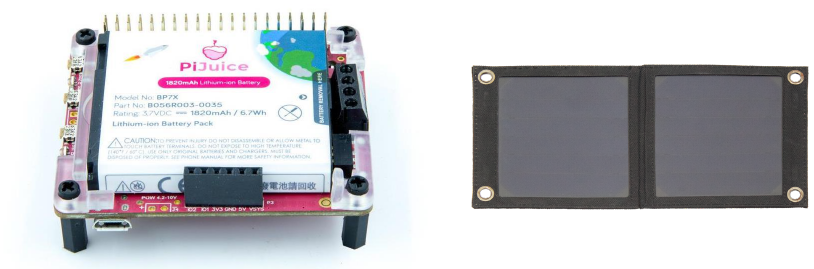
Figure 4. ( Left ) Raspberry Pi with a PiJuice Hat battery on top of it, ( Right ) PiJuice Solar panel (6 Watt model). More details available at https://uk.pi-supply.com/products/pijuice-standard (accessed on 28 July